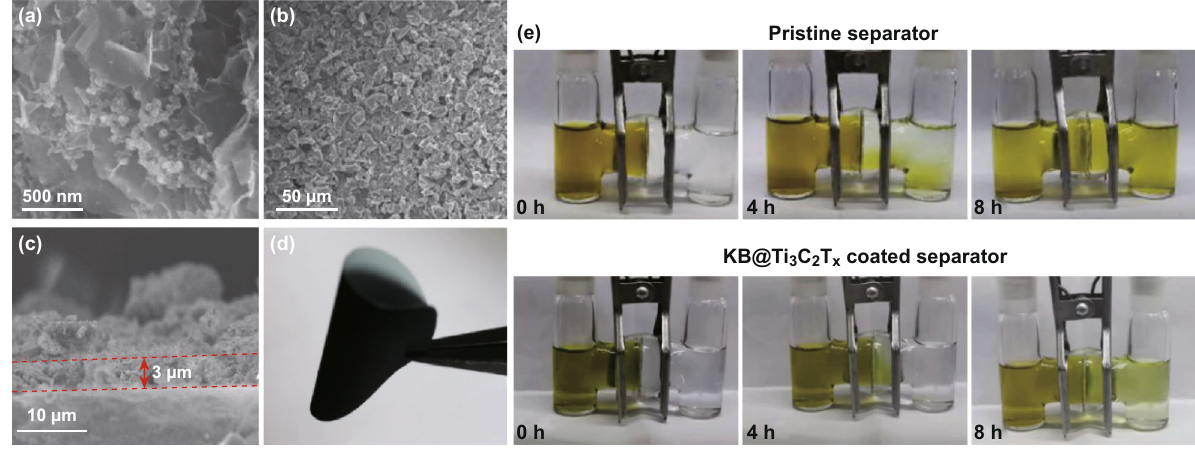
Fig. 4 a SEM image of KB@Ti 3 C 2 T x . b SEM image of KB@Ti 3 C 2 T x -coated separator. c Cross-sectional SEM image of KB@Ti 3 C 2 T x -coated separator. d Photograph of the